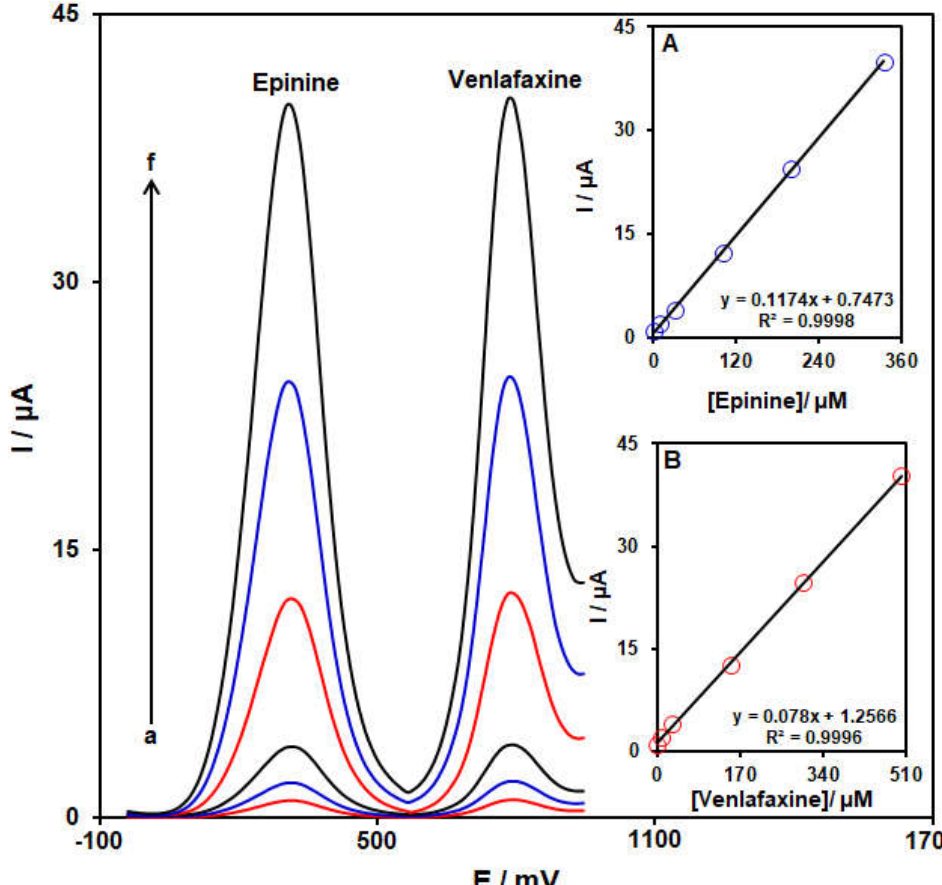
Figure 10. Differential pulse voltammograms captured for NiCo-MOF/SPGE in PBS (pH 7.0, 0.1 M) with variable epinine and venlafaxine levels (a−f): (a) 0.5 + 1.0, (b) 10.0 + 10.0, (c) 30.0 + 30.0, (d) 100.0 + 150.0, (e) 200.0 + 300.0, and (f) 335.0 + 500.0 µM of epinine and venlafaxine level, sequen- tially. Insets: ( A ): Plot of peak current as a function of epinine levels; ( B ): Plot of peak current as a function of venlafaxine levels.